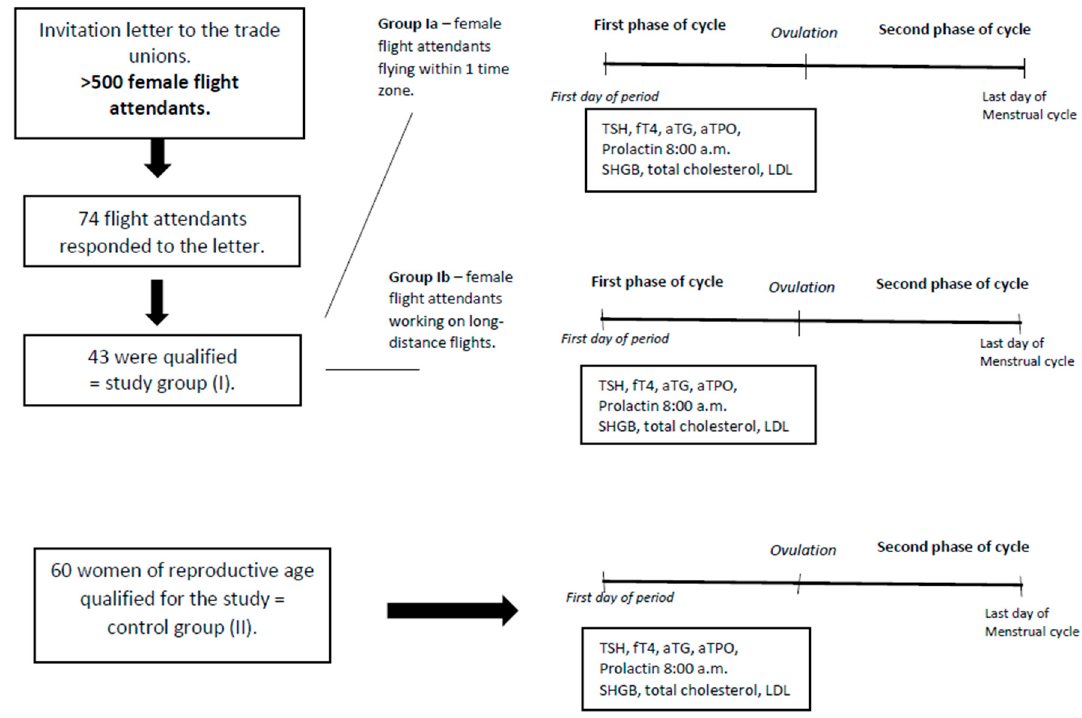
Figure 1. Study design. TSH—thyroid-stimulating hormone; fT4—free thyroxine; aTG—antibodies to thyroglobulin; aTPO—antibodies to thyroperoxidase; SHGB—sex hormone binding globulin; LDL—low-density